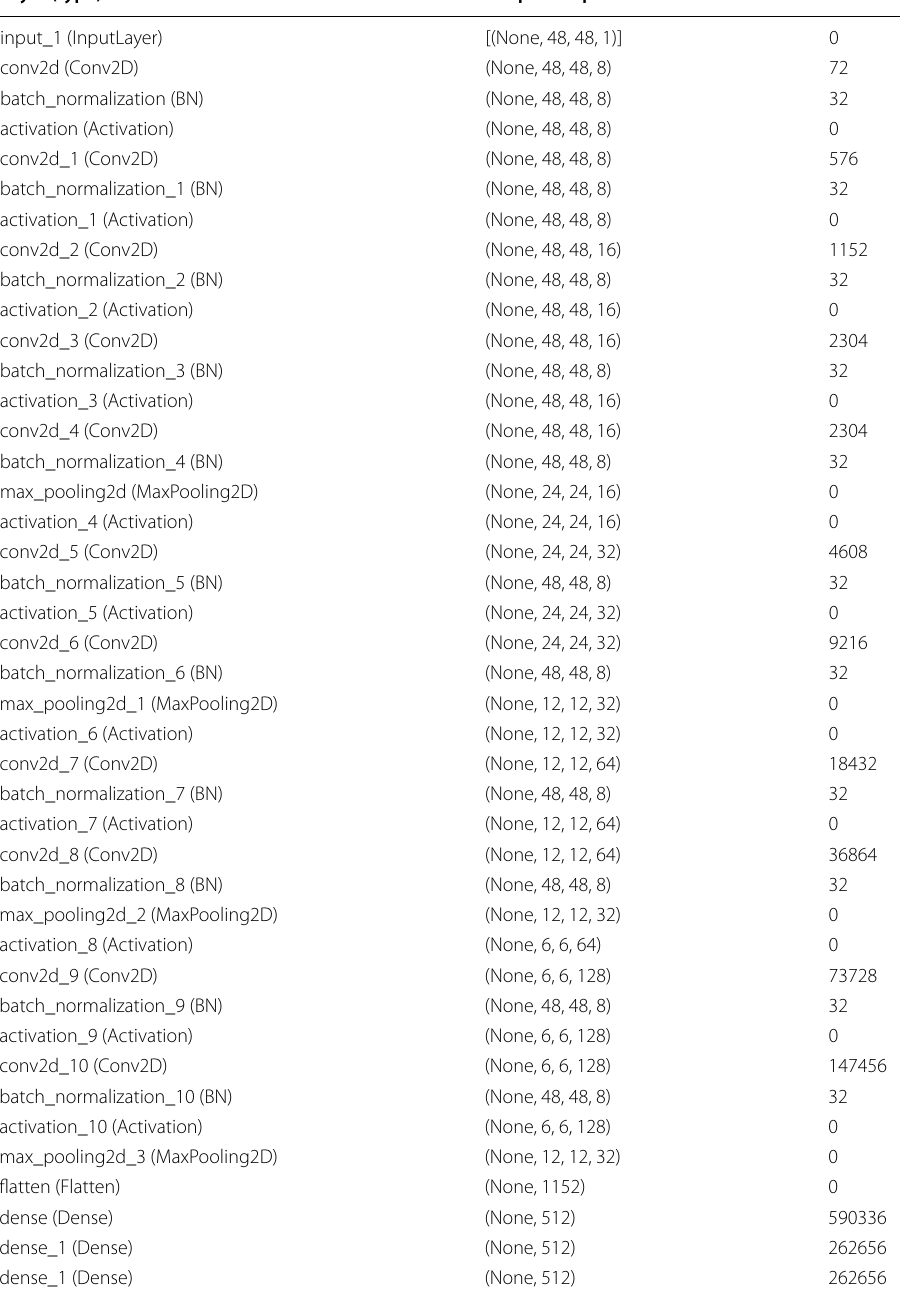
Table 4 Architecture with-out separable convolution, with dense layers (ARCH-4) Layer